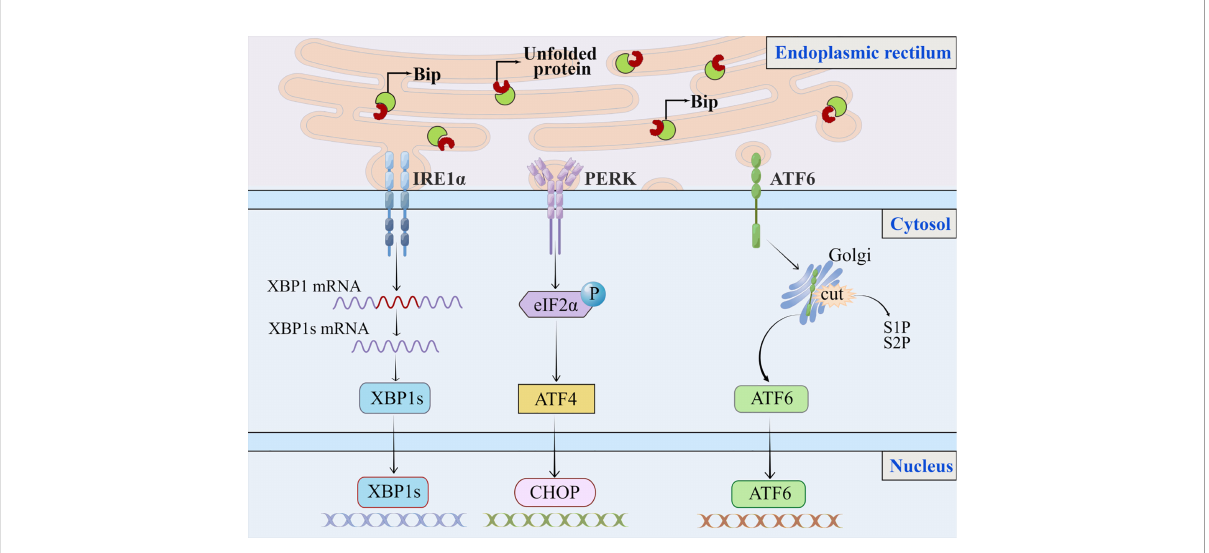
FIGURE 1 The classic endoplasmic reticulum stress signaling pathway. In response to stress or physiological conditions, the endoplasmic reticulum molecular chaperone GRP78/Bip binds to three transmembrane ER resident pressure sensors (A) PERK, (B) IRE1, and (C) ATF6. When endoplasmic reticulum stress occurs, misfolded or unfolded proteins accumulate in the lumen of the ER, GRP78/Bip dissociates from these three pressure sensors and binds to misfolded or unfolded proteins, triggering the UPR. The extent to which ER stress and the UPR contribute to the NAFLD process may depend on the ability of the UPR to mitigate the damage that leads to disrupted ER homeostasis. (A) PERK phosphorylates eIF2 a . To alleviate protein overload in the ER, phosphorylation of eIF2 a reduces translation of mRNAs but can increase translation of some speci fi c mRNAs, such as ATF4.(B) Accumulation of unfolded protein in ER induces oligomerization of IRE1 a on ER membrane and autophosphorylation of IRE1 a cytoplasmic structural domain, and autophosphorylation of IRE1 a can further activate ribonuclease activity; and IRE1 has endonuclease activity, which will splice XBP1 mRNA into XBP1s, encoding transcription factors and activating expression of UPR target genes.(C) ATF6 moves as a vesicle from the ER to the Golgi apparatus, where it is cleaved by S1P and S2P then migrates to the nucleus to activate XBP1 and genes involved in ER protein folding and secretion, such as CHOP. ER, endoplasmic reticulum; UPR, unfolded protein response; S1P, site 1 protease; S2P, site 2